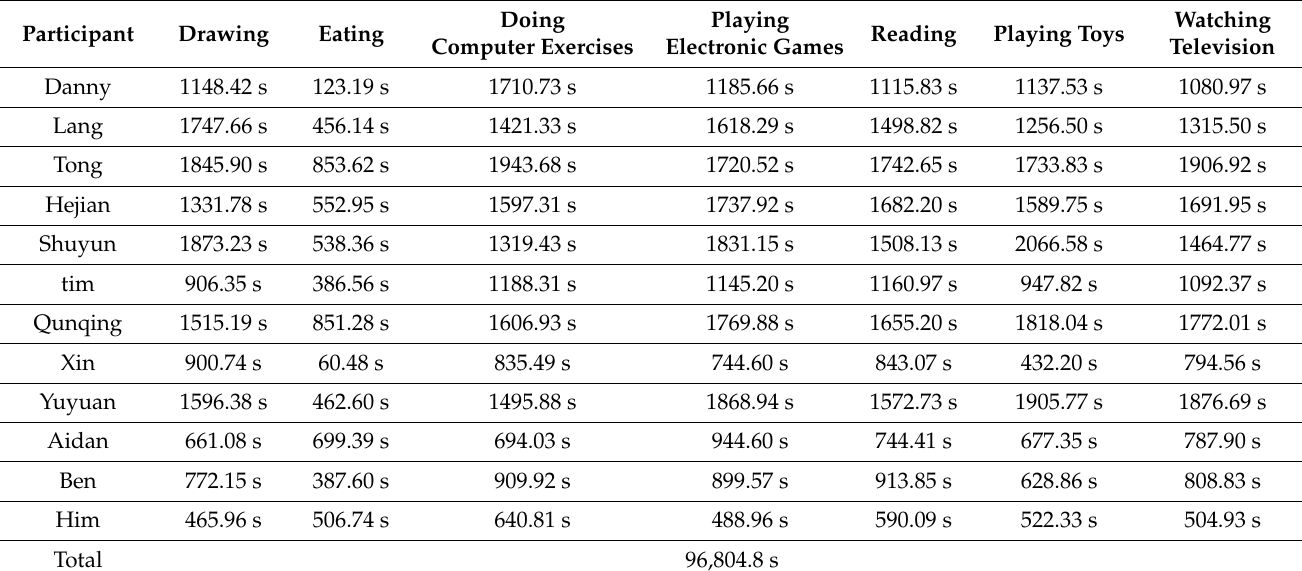
Table 11. The total times required for performing the attention assessments for each individual for performing each activity under both the concentration state and the immersion state via our proposed method with all three classifiers.